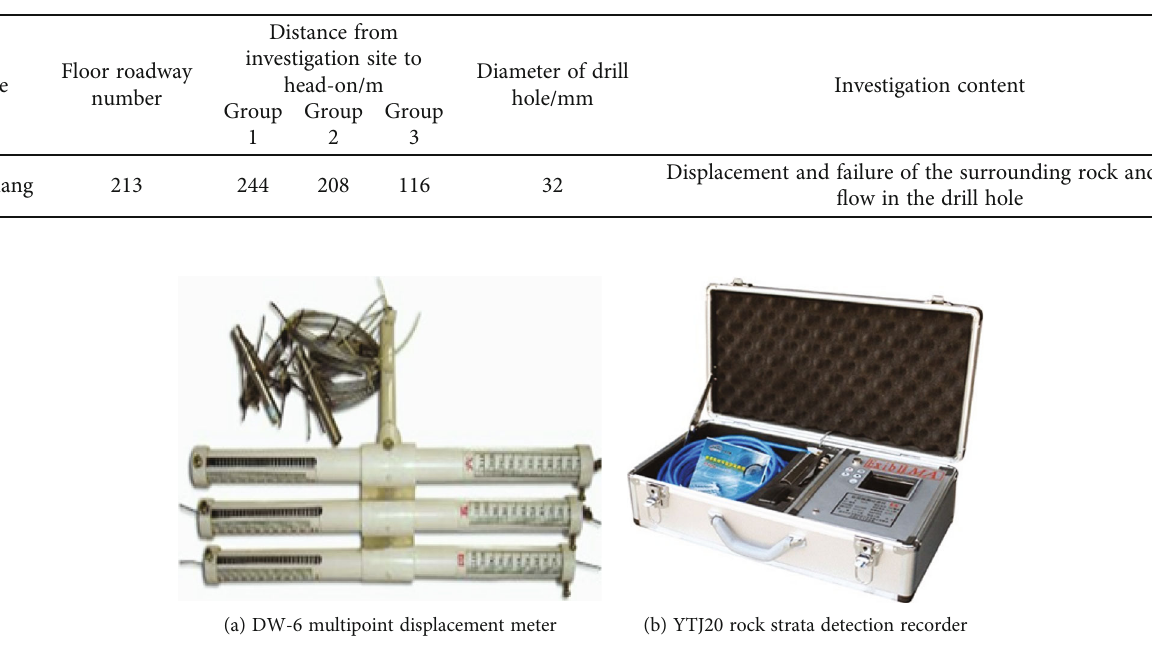
Figure 14: Real pictures of instruments used for investigating pressure relief e ff ect.